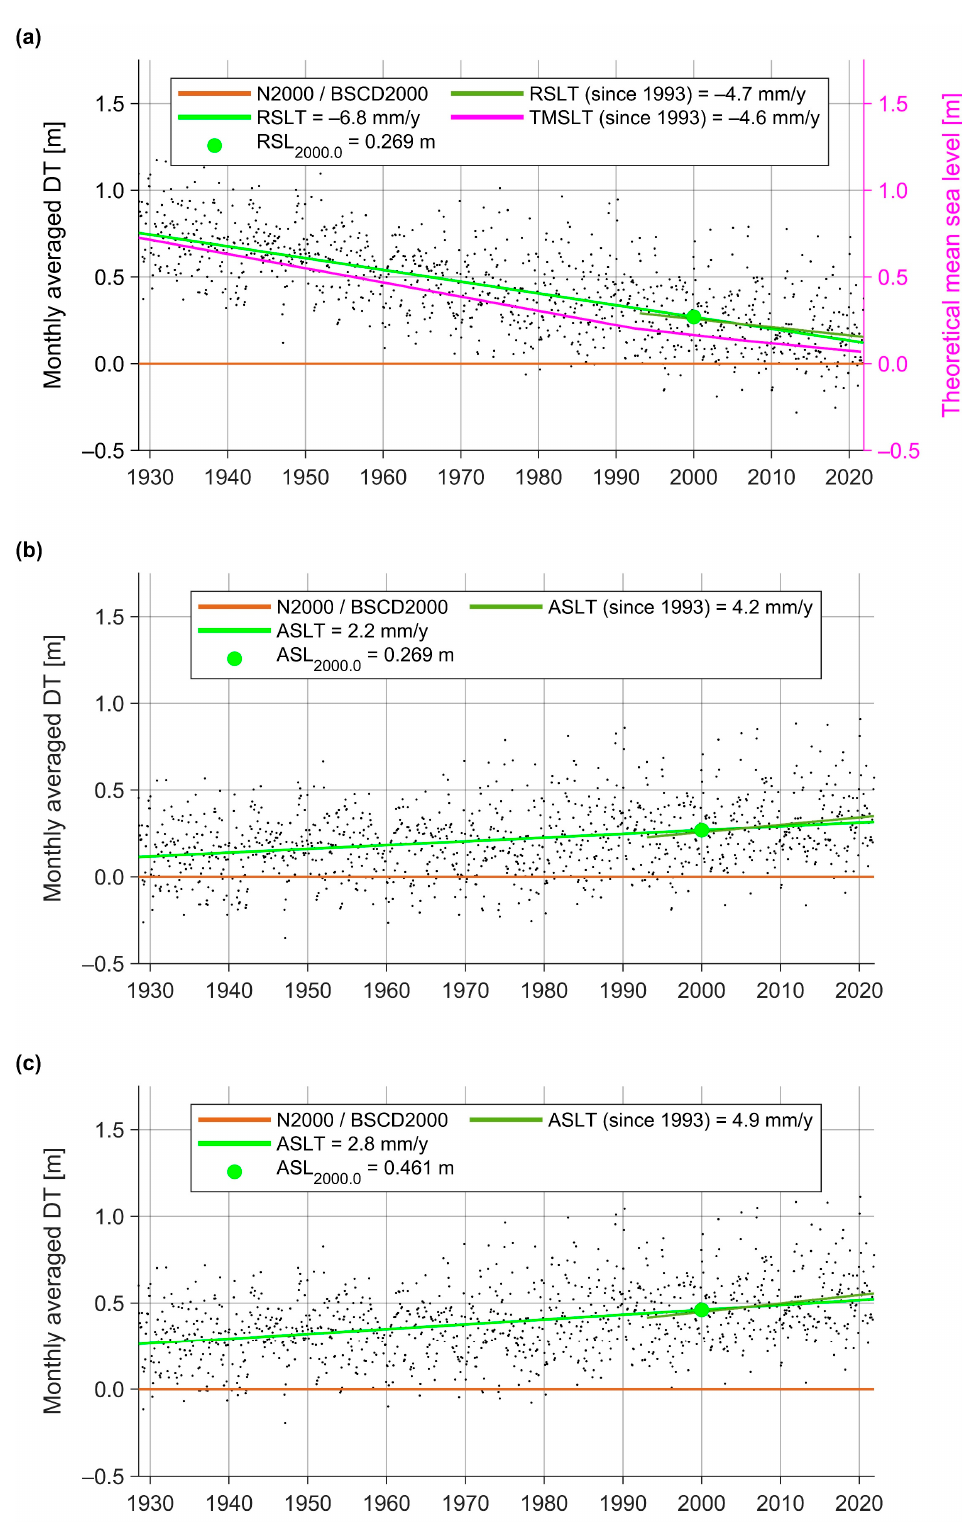
Figure 5. Monthly averaged ( a ) relative and ( b ) absolute DT of Pietarsaari TG (cf. Figure 2 for its location) and the estimated sea level trends. In ( c ) are presented absolute DT and the estimated sea level trends containing purposefully induced errors (i.e., VLM geocentric and an arbitrary reference epoch 1980.0 are used).